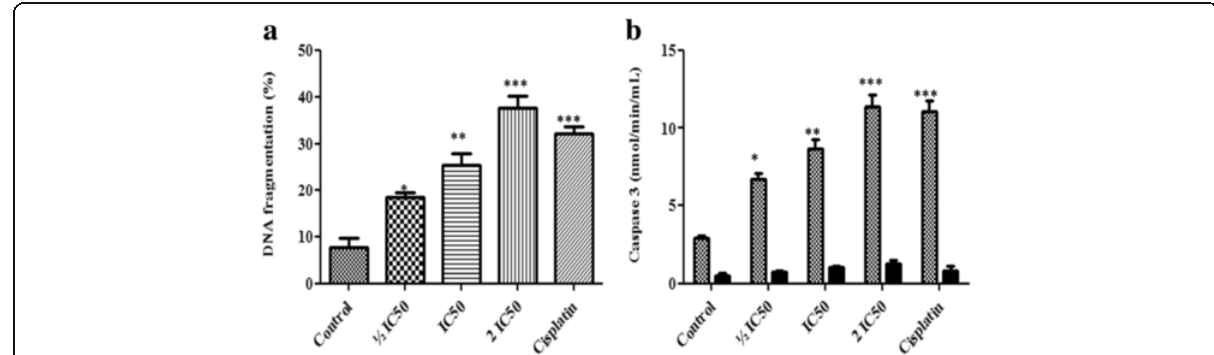
Fig. 5 Effect of F3 fraction on the percentage of DNA fragmentation and caspase-3 activity. a Effect of F3 fraction on percentage of DNA fragmentation in NCI-H358 cells. b Caspase-3 activity in NCI-H358 cells was analyzed using CASP-3-C colorimetric assay kit. Cells were treated with F3 fraction (½ IC 50 , IC 50 and 2 IC 50 ) for 24 h with (black bars) or without (grey bars) caspase-3 inhibitor Ac-DEVD-CHO. The results are expressed as the mean±SD of triplicate determinations, representative of three independent experiments. Significances indicated were in comparison to control (* p <0.05; ** p <0.01; *** p <0.001 vs.